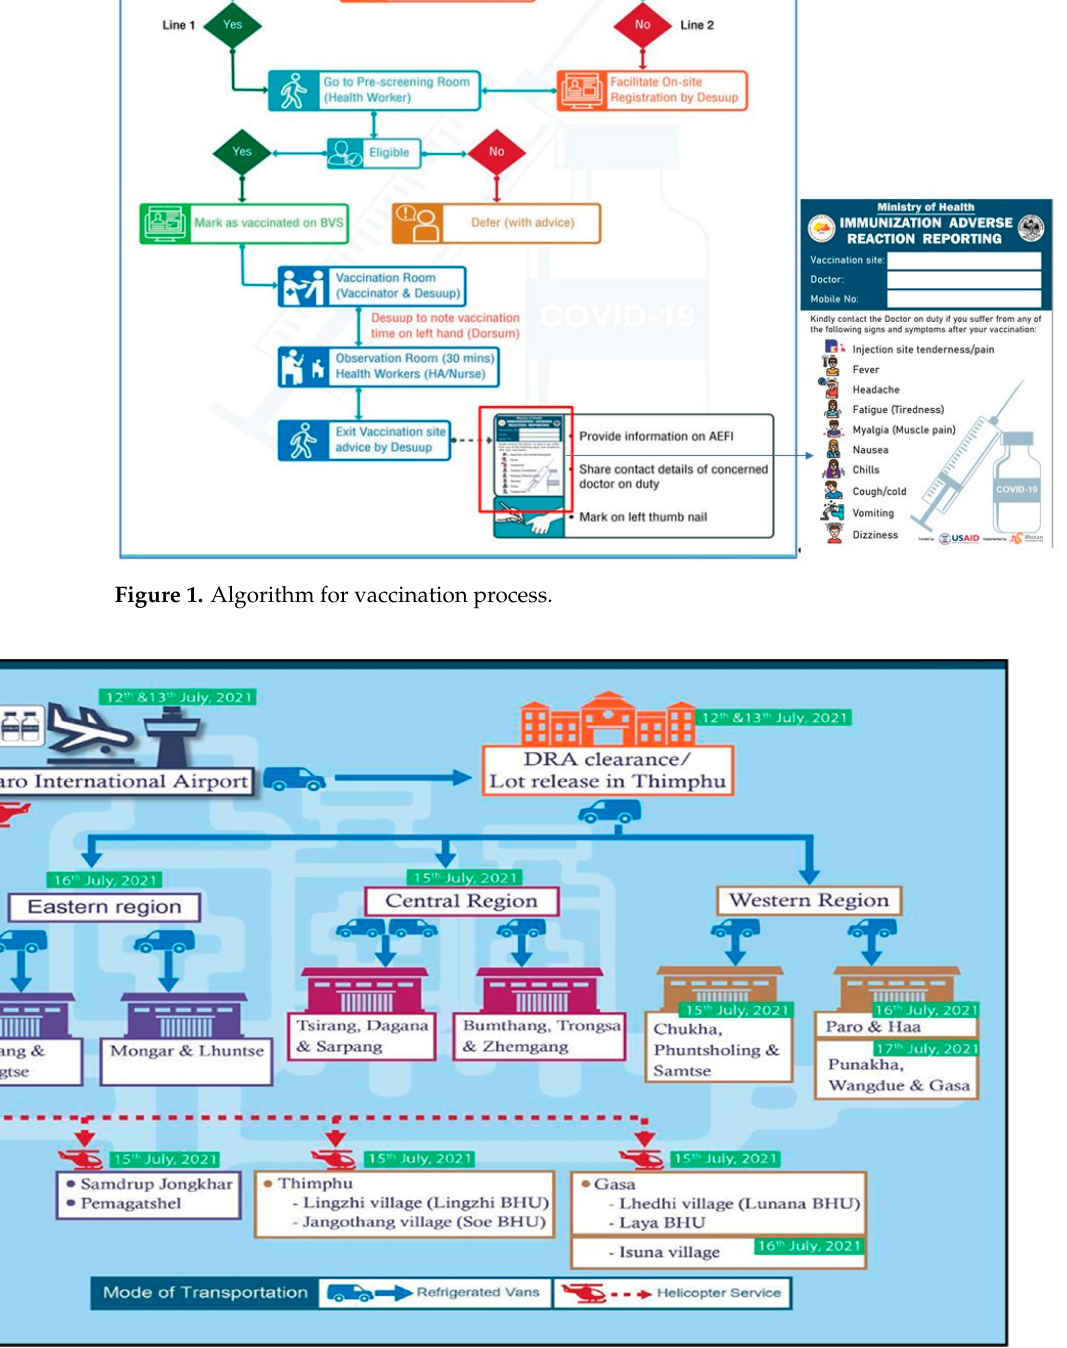
Figure 2. Vaccine transport and distribution plan.